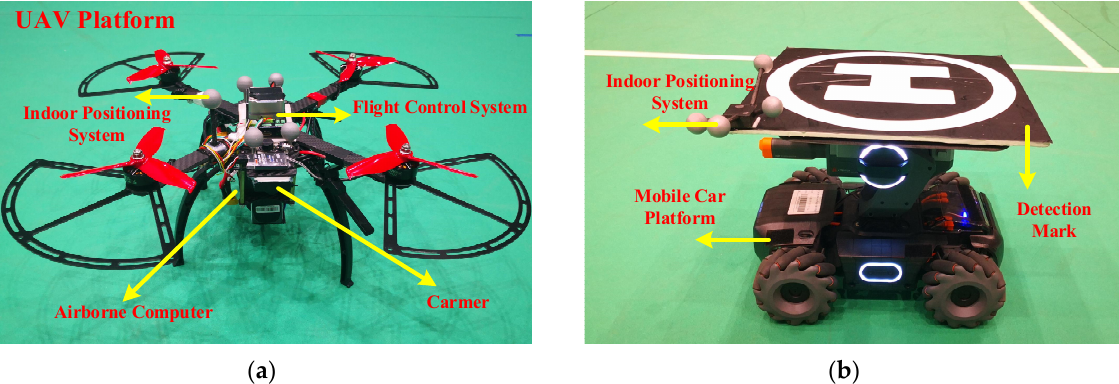
Figure 10. ( a ) The UAV platform is used for flight tests in the real world. ( b ) The target platform is used for flight tests in the real world.